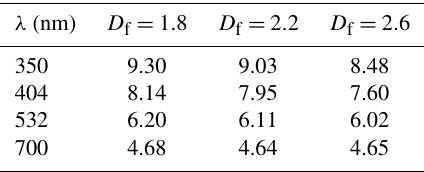
Table 2. MAC (m 2 g − 1 ) for bare BC at different D f values ( r g